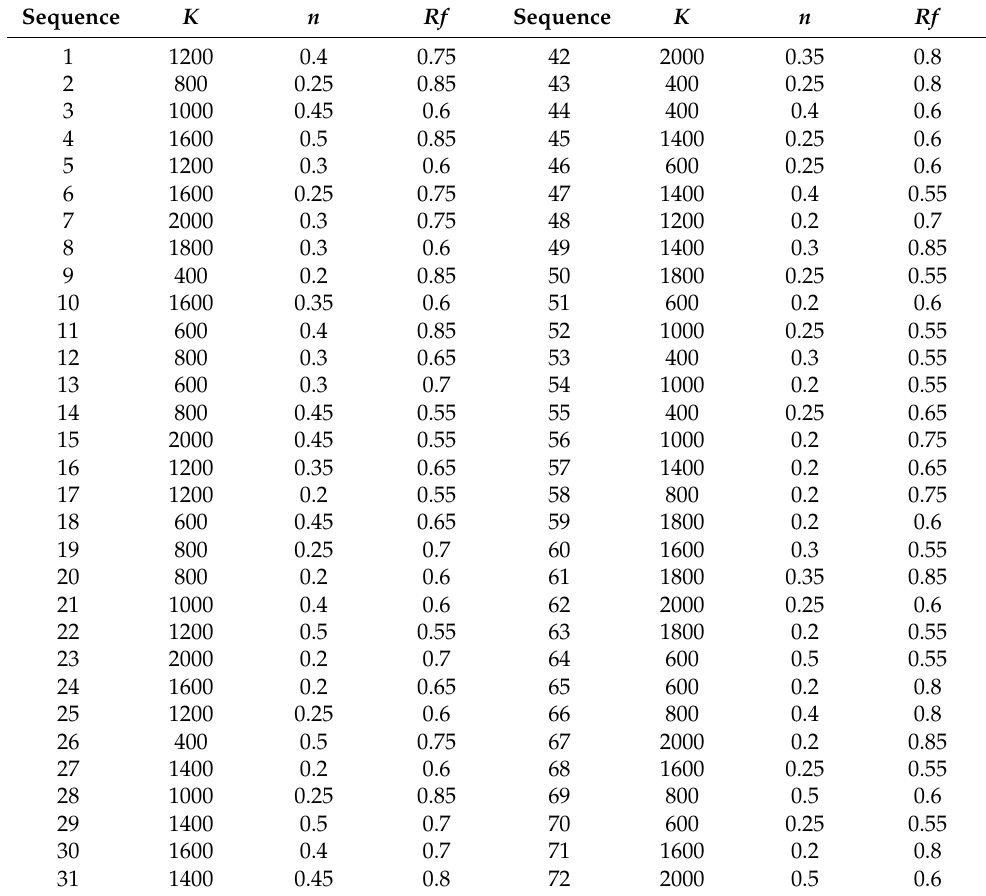
Table 6. Combinations of material